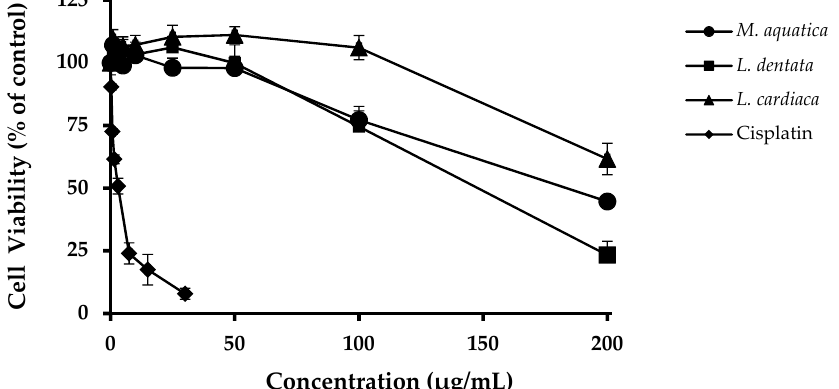
Figure 1. Viability of HepG2 cells exposed for 72 h to a concentration range of cisplatin (0.3 to 30 µ g / mL), used here as a toxic positive control, or of hydroethanolic extracts (1 to 200 µ g / mL) obtained from M. aquatica , L. dentata and L. cardiaca . Values are means ± SD of the percentage of cell viability with respect to control untreated cells.